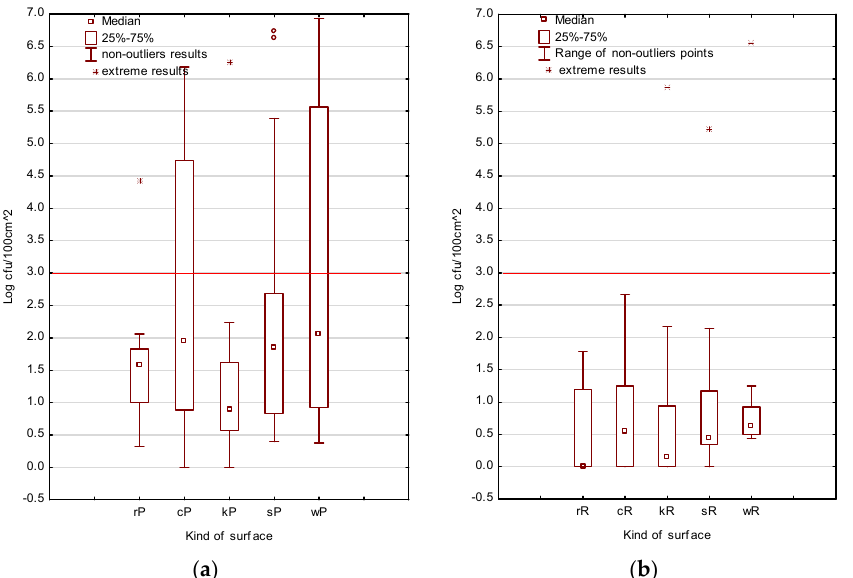
Figure 2. Mean contamination of TVC on analysed surfaces in food truck outlets ( n = 20). ( a ) Petri-